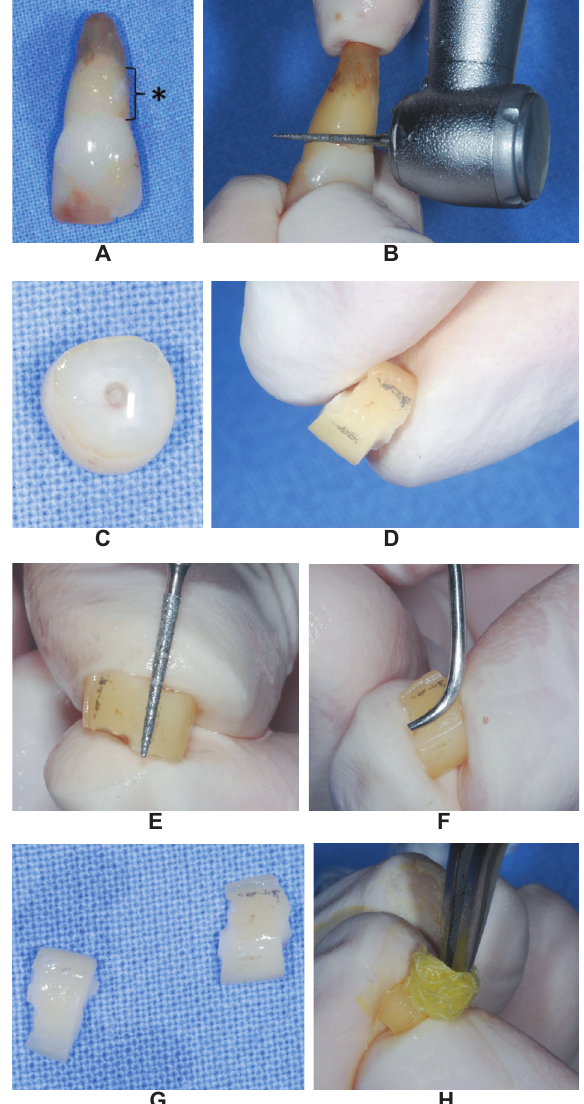
Figure 1- Specimen preparation. A: extracted teeth in (cid:2)(cid:3)(cid:4)(cid:5)(cid:3)(cid:6)(cid:7)(cid:3)(cid:8)(cid:6)(cid:9)(cid:4)(cid:10)(cid:8)(cid:11)(cid:10)(cid:8)(cid:9)(cid:6)(cid:12)(cid:11)(cid:13)(cid:7)(cid:6)(cid:14)(cid:15)(cid:6)(cid:7)(cid:3)(cid:8)(cid:6)(cid:13)(cid:14)(cid:14)(cid:7)(cid:6)(cid:2)(cid:11)(cid:10)(cid:6)(cid:4)(cid:9)(cid:8)(cid:16)(cid:7)(cid:4)(cid:17)(cid:8)(cid:9)(cid:6)(cid:18)(cid:19)(cid:6)(cid:7)(cid:3)(cid:8)(cid:6) absence of periodontal ligament remnants (*); B: tooth crown being transversely cut at the cementoenamel with a water-cooled high-speed bur; C: radicular dish obtained (cid:18)(cid:19)(cid:6)(cid:10)(cid:8)(cid:5)(cid:7)(cid:4)(cid:14)(cid:16)(cid:4)(cid:16)(cid:20)(cid:6)(cid:7)(cid:3)(cid:8)(cid:6)(cid:13)(cid:14)(cid:14)(cid:7)(cid:6)(cid:21)(cid:6)(cid:22)(cid:22)(cid:6)(cid:11)(cid:2)(cid:11)(cid:19)(cid:6)(cid:15)(cid:13)(cid:14)(cid:22)(cid:6)(cid:7)(cid:3)(cid:8)(cid:6)(cid:17)(cid:13)(cid:10)(cid:7)(cid:6)(cid:5)(cid:23)(cid:7)(cid:6)(cid:4)(cid:16)(cid:6)(cid:7)(cid:3)(cid:8)(cid:6) apical direction; D: pencil marks made 4 mm apart from each other on the mesial and distal surfaces of the dishes where grooves were made (E), delimiting an area of 2 mm